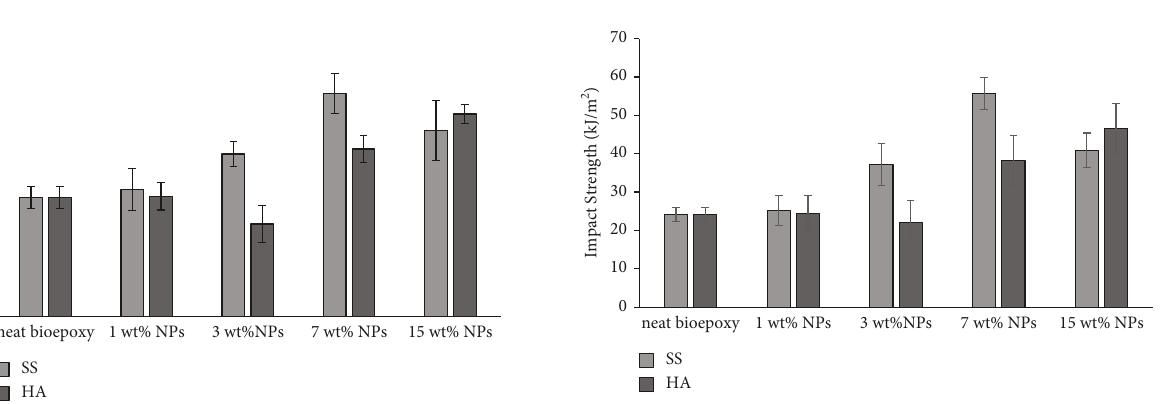
Figure 6: Influence of the incorporation of different mass fractions of HA or SS nanoparticles on the impact strength of